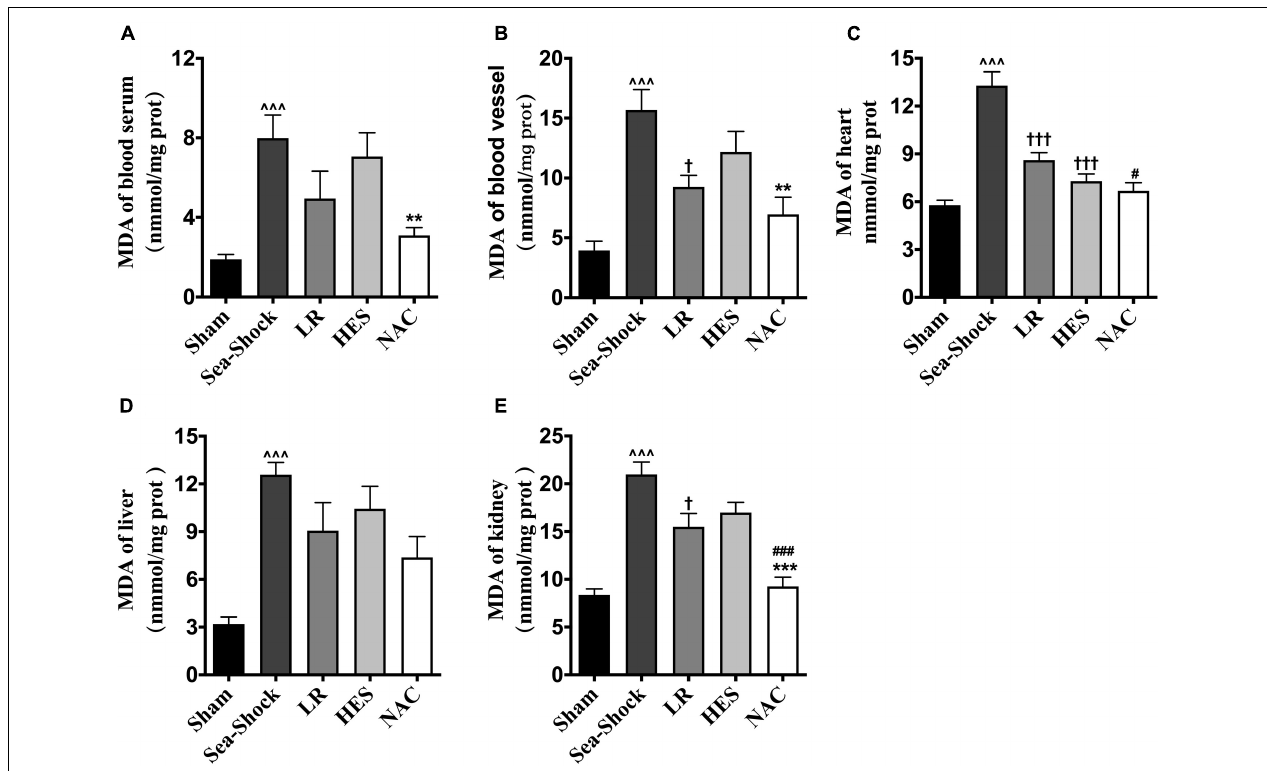
FIGURE 6 | Effects of LR solution, HES solution, and LR solution with the addition of NAC (30 mg/kg) on MDA. (C) MDA of heart; (A) MDA of blood serum; (B) MDA of blood vessel; (E) MDA of kidney; (D) MDA of liver. LR, Lactated Ringer’s; HES, Hetastarch; NAC, LR solution with the addition of NAC (30 mg/kg). Data presented as mean ± standard deviation ( n = 8/group). ∧∧∧ P < 0.001, Sea-Shock group versus baseline; † P < 0.05, ††† P < 0.001, LR group or HES group versus Sea-Shock group; # P < 0.05, ### P < 0.001, LR group versus NAC group; ** P < 0.01, *** P < 0.001, HES group versus NAC